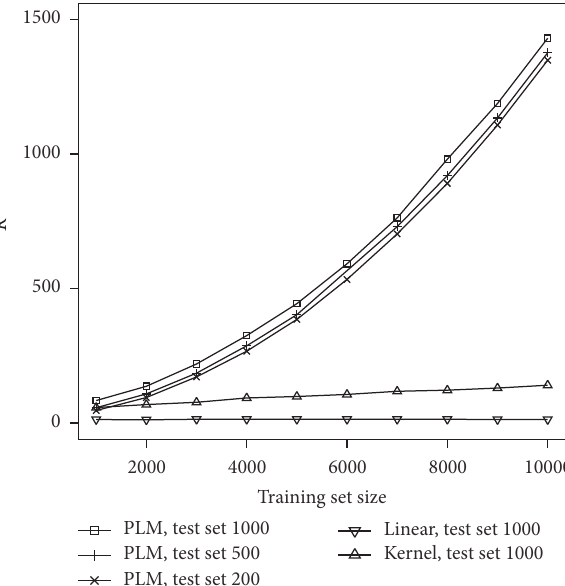
Figure 5: Forecast quality dependence on training set size for traffic data.